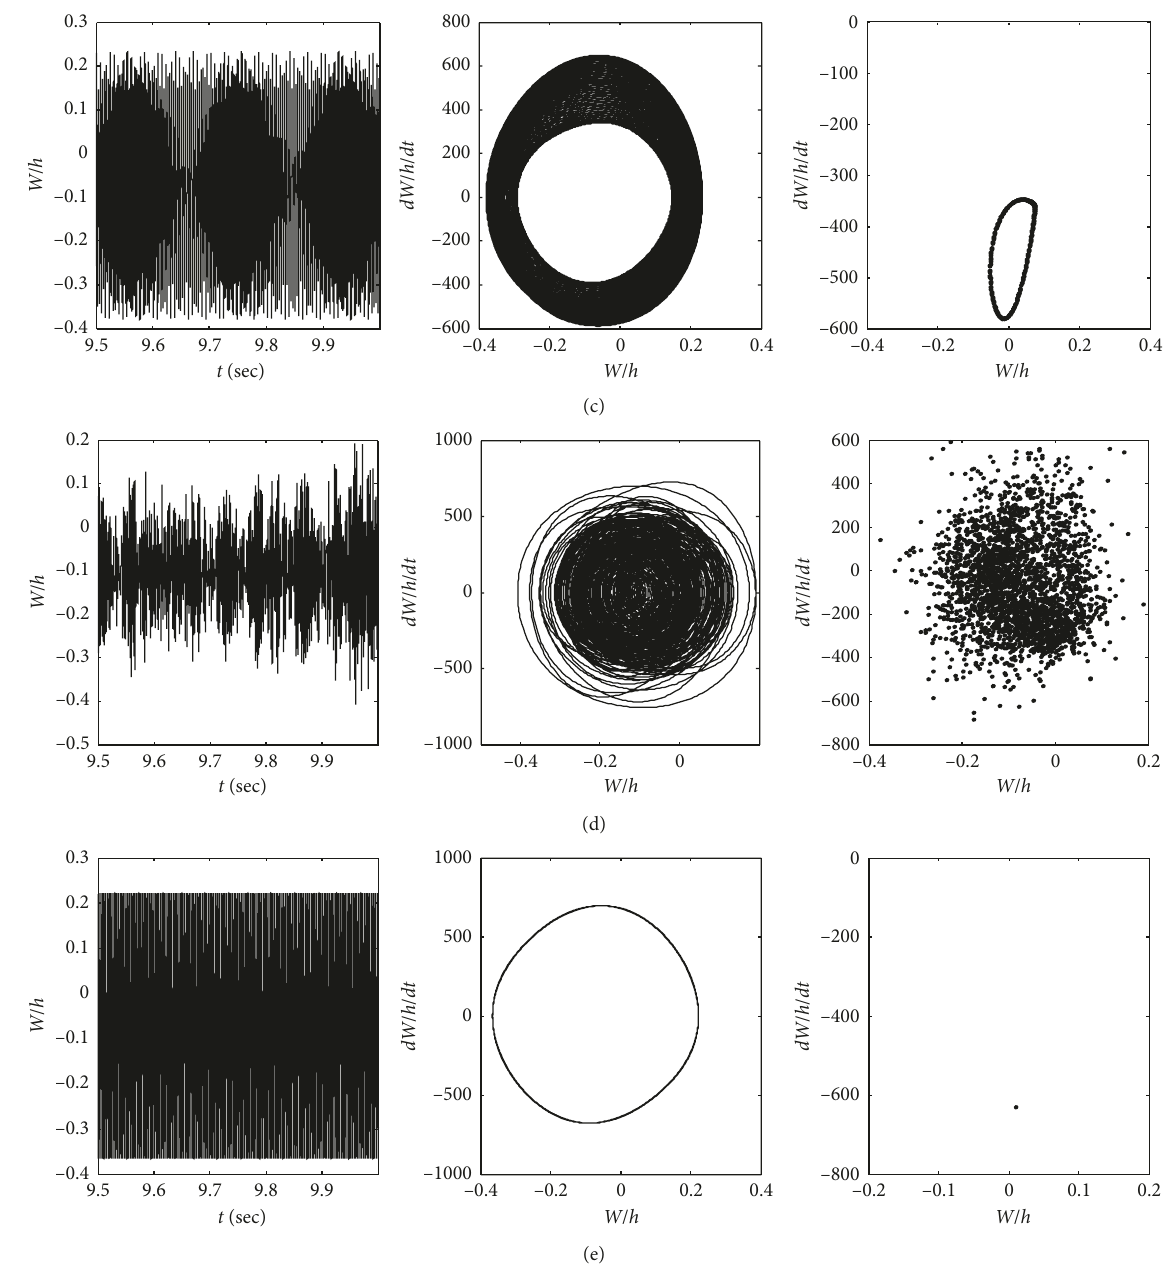
Figure 8: Time history, phase portrait, and Poincar´e maps under different dynamic pressures. (a) λ � 490. (b) λ � 1000. (c) λ � 1220. (d) λ � 1480. (e) λ �